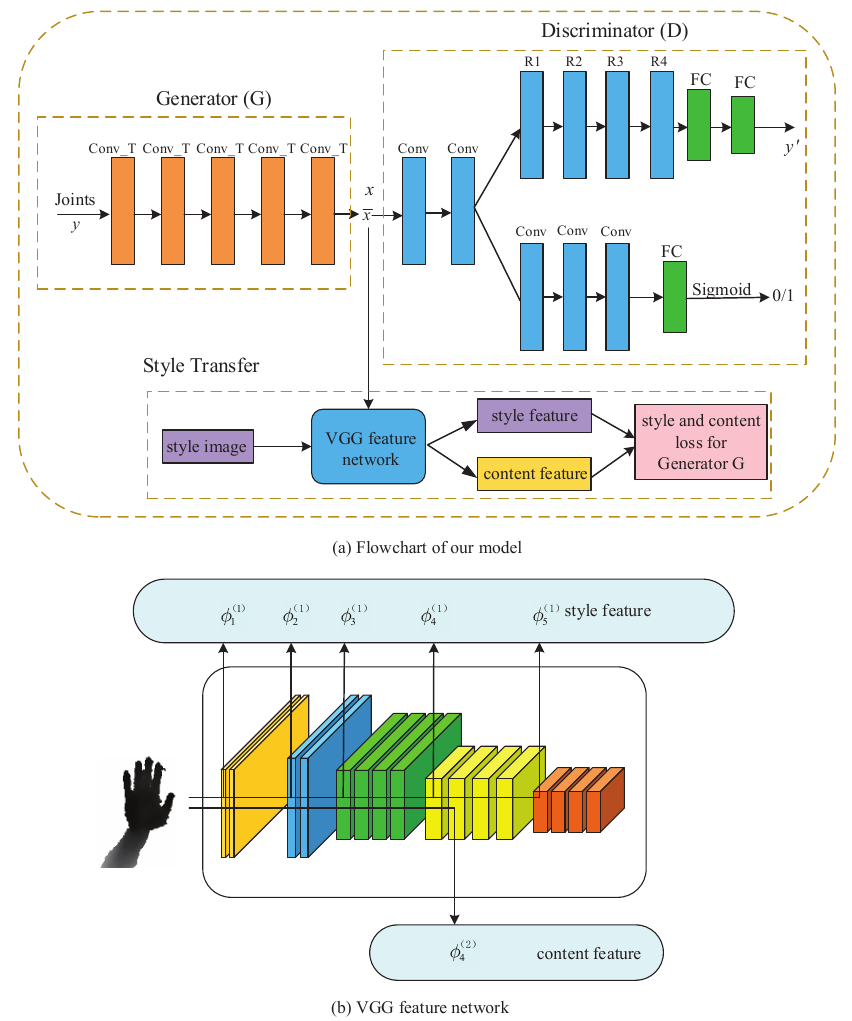
Figure 1. ( a ) Flowchart of the proposed method, covering the generator, the discriminator, and style-transfer networks in detail. The VGG-19 feature networks are described in ( b ), where the top row represents the style layers (e.g., φ 1